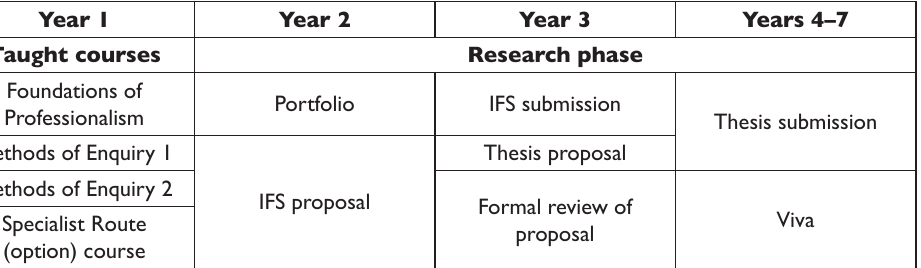
Table 1: EdD programme